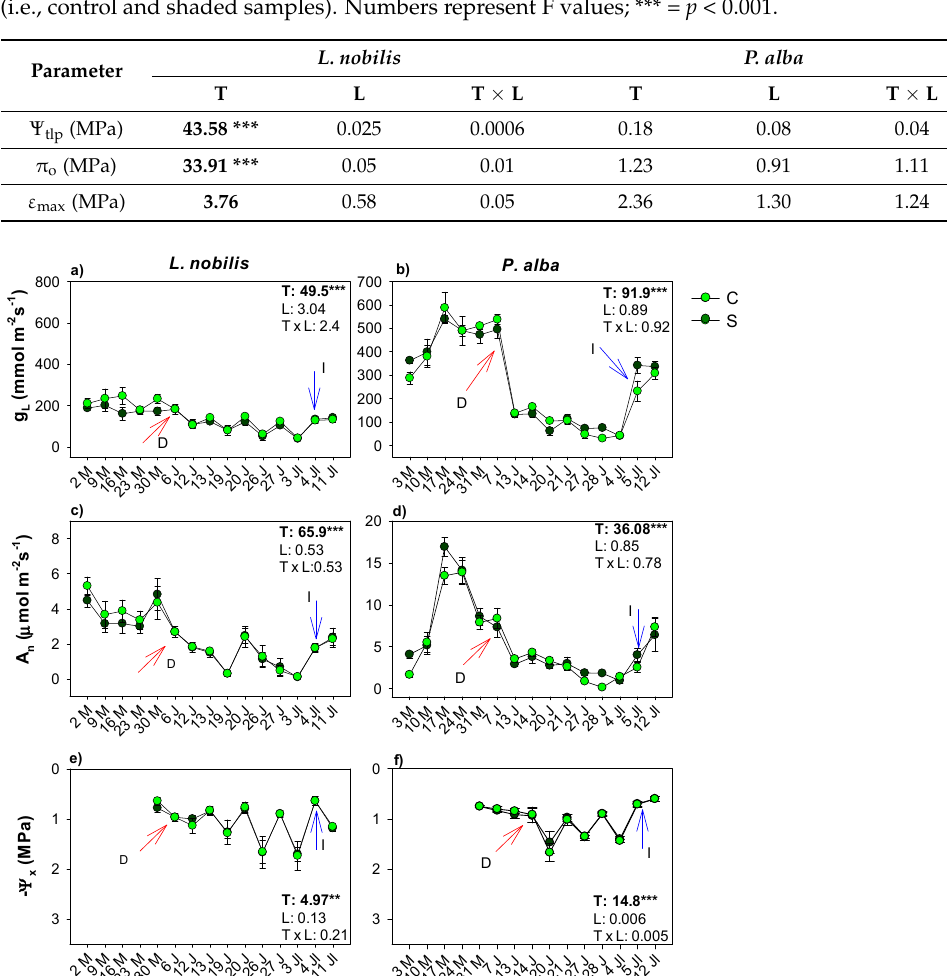
Figure 2. Mean values ± SEM of ( a , b ) stomatal conductance to water vapor, g L ; ( c , d ) photosynthetic rate (A n ) and ( e , f ) xylem water potential ( Ψ X ) as recorded in May (M), June (J) and July (Jl) in control (C, light green circle) and shaded samples (S, dark green circle) of L. nobilis and P. alba plants. Arrows indicate the day starting drought treatment (D) and re-irrigation (I). F values, as obtained by the two-way ANOVA analysis, are reported. Time of measurement, T, and light treatment, L (i.e., control and shaded samples) are the explanatory variables ** = p < 0.01; *** = p < 0.001.